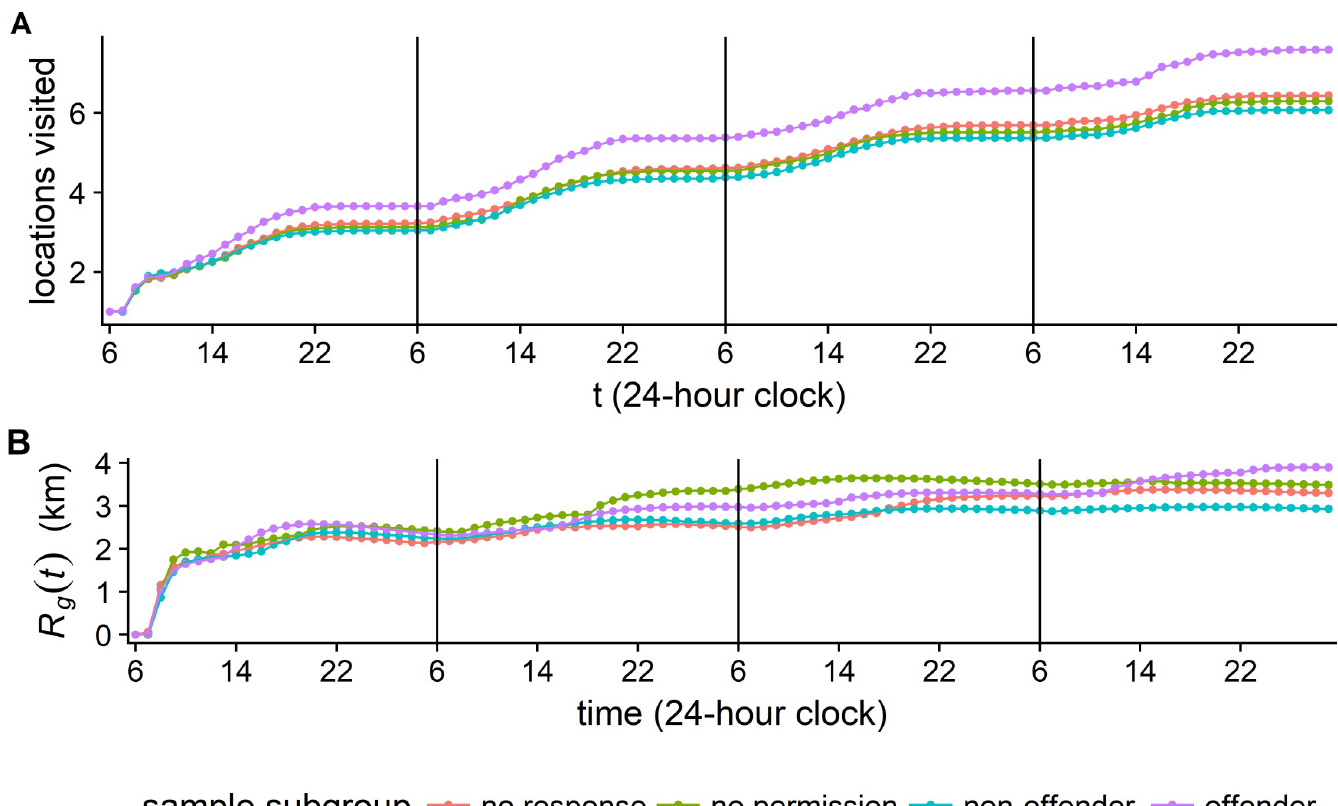
Fig 2. Development of number of unique locations visited and radius of gyration over time. (A) The cumulative number of visited locations grows linearly over time, remains stable during sleeping hours and does not reach an asymptotic stable level within the observation period of four days. (B) Apart from the first few hours on the first day covered, the radius of gyration grows sub-linearly, slightly decreases during sleep due to 9 hours of immobility, and reaches a stable level of approximately 3km after two days already. The adolescents slept almost 9 hours per day on average, typically at home during the night between 22:00 and 7:00.